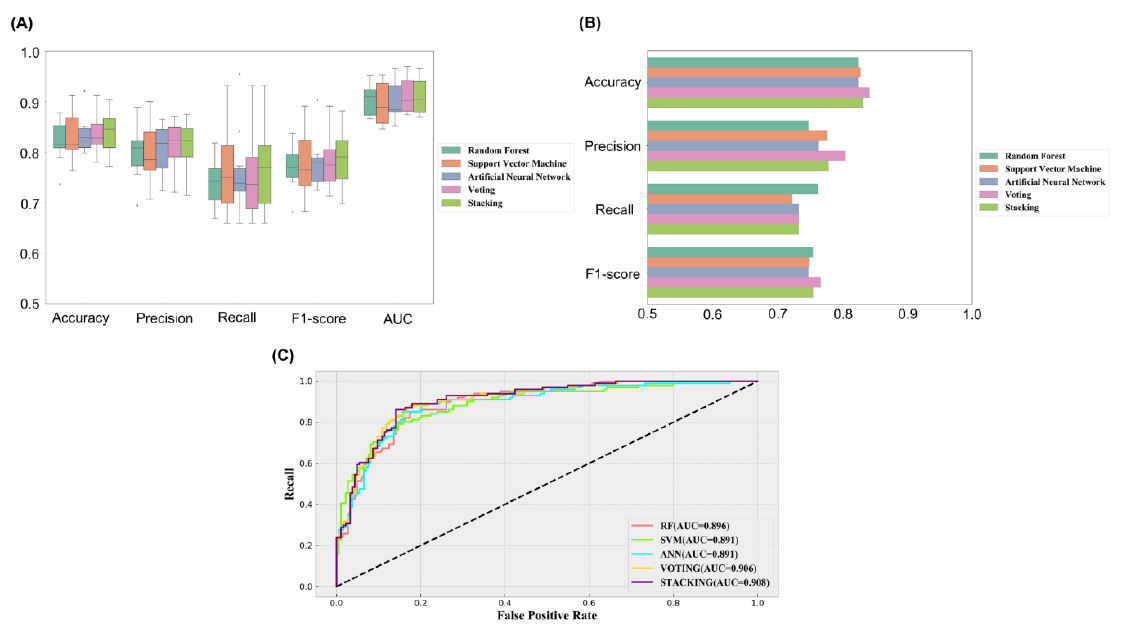
Figure 2. ( A ) The five models’ prediction performance in 10-fold cross-validation for training set. ( B ) and ( C ) The five models’ prediction performance for test set. Table 1. Performance metrics of the JNK1 models on training and test